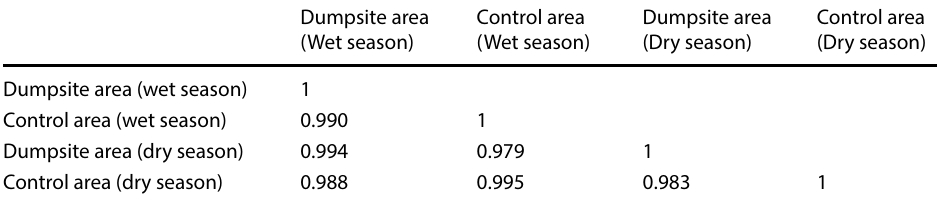
Correlation is significant at the